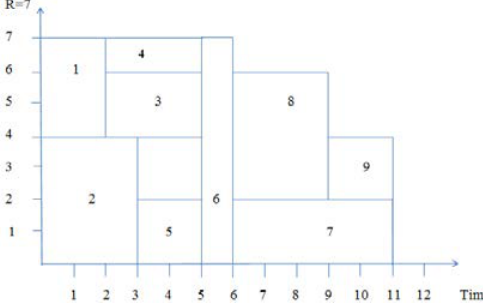
Fig. 3. The scheduling obtained by DS algorithm for sample given in Fig.